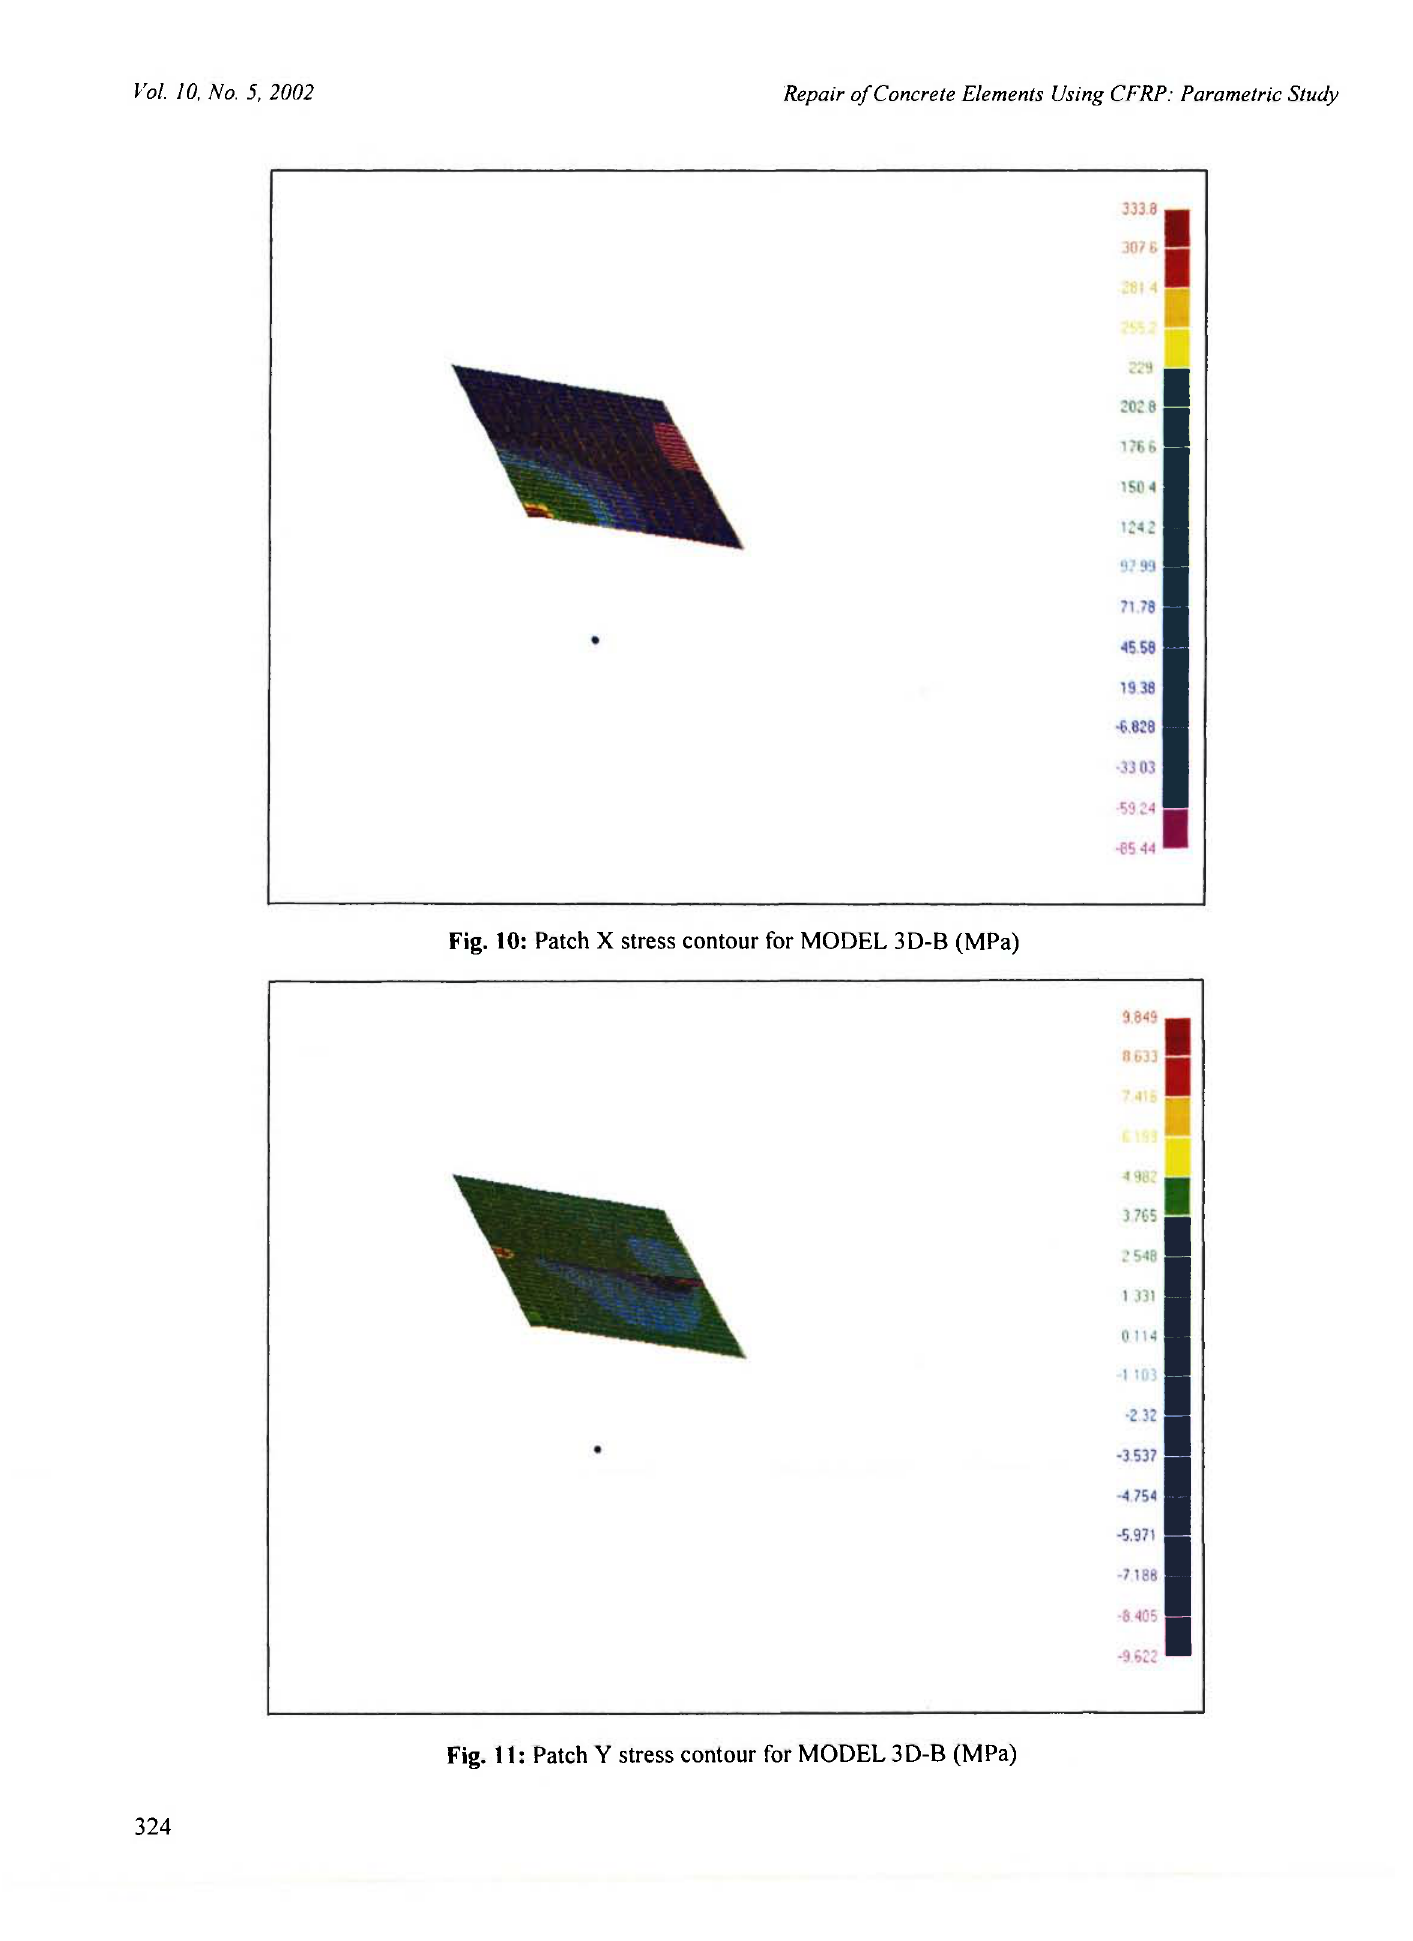
Fig. 11: Patch Y stress contour for MODEL 3D-B